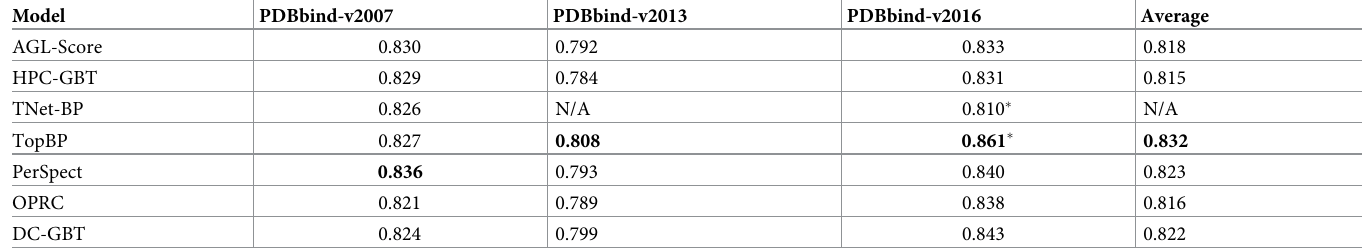
Table 4. The comparison of our DC-GBT model with advanced-mathematical based machine learning models [14, 18, 20, 30, 32, 33]. Note that values marked with � uses PDBbind-v2016 core set ( N = 290). Model